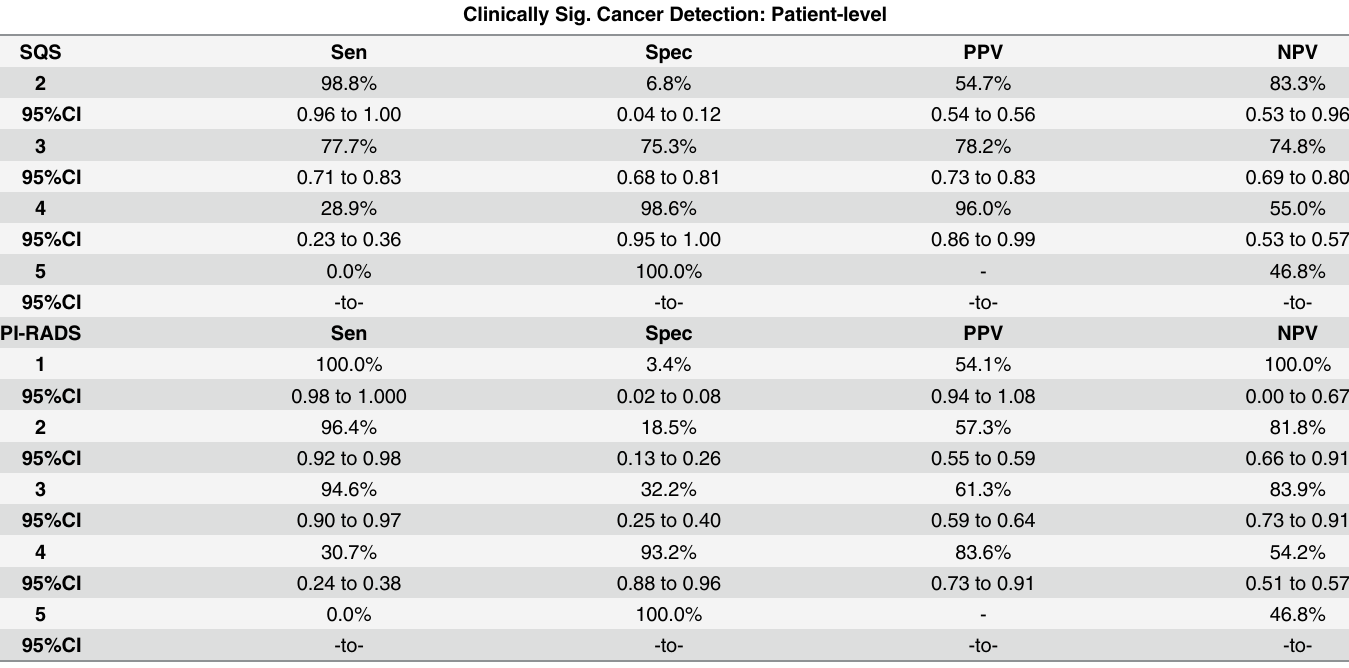
Table 2. Positive Predictive Value, Negative Predictive Value, Sensitivity and Specificity at each cut point in each scoring system for the detection of clinically significant prostate cancer: Patient-level analysis. Clinically Sig. Cancer Detection: